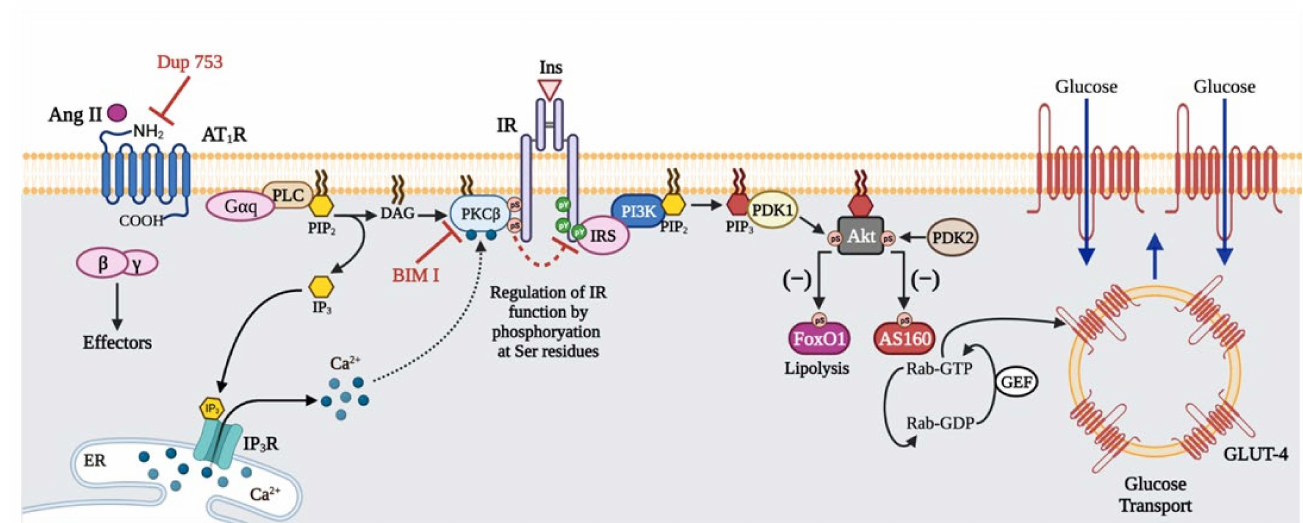
Figure 8. A model of desensitization of the insulin signaling pathway by angiotensin II (Ang II) in 3T3-L1 adipocytes. When adipose cells are stimulated with Ang II, the endogenous AT 1 R is activated, leading to PKC β activation, which in turn interacts with the insulin receptor (IR) and phosphorylates it on serine (Ser) residues impairing insulin actions such as glucose uptake and regulation of lipolysis. Blue arrows indicate Ang II signaling pathways. Black arrows indicate insulin signaling pathways. Minus sign ( − ) means negative regulation of FoxO1 and AS160 pathways by Akt. Red lines indicate the effect of PKC inhibitors (BIM I and Gö6976) and AT 1 R antagonist (DuP 753). Red dashed arrow indicates that PKC-mediated Ser-phosphorylation regulates IR function. Figure created with